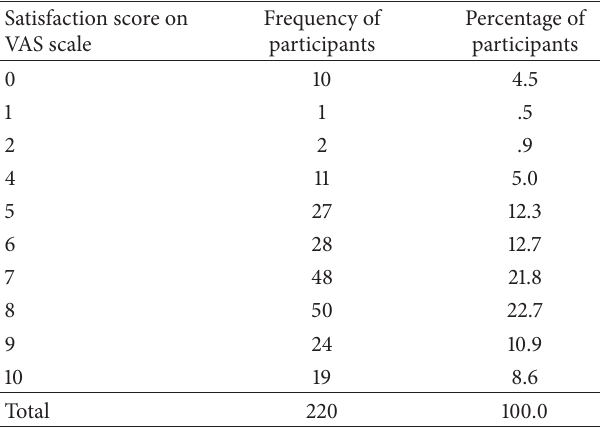
Table 2: Distribution of satisfaction score among the study popula- tion ( 𝑁 = 220